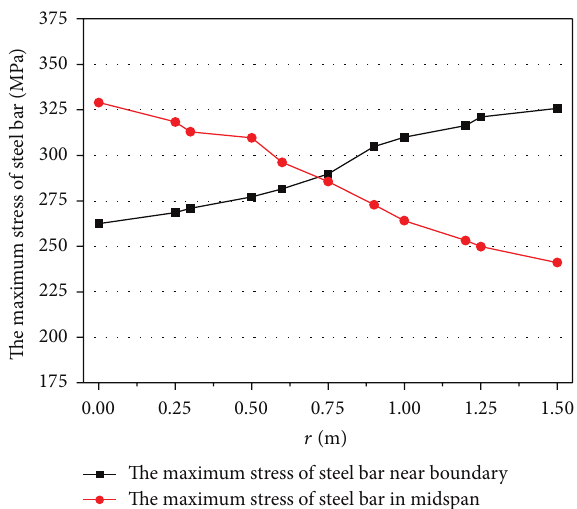
Figure 10: Maximum stress of steel bar under different explosive positions.